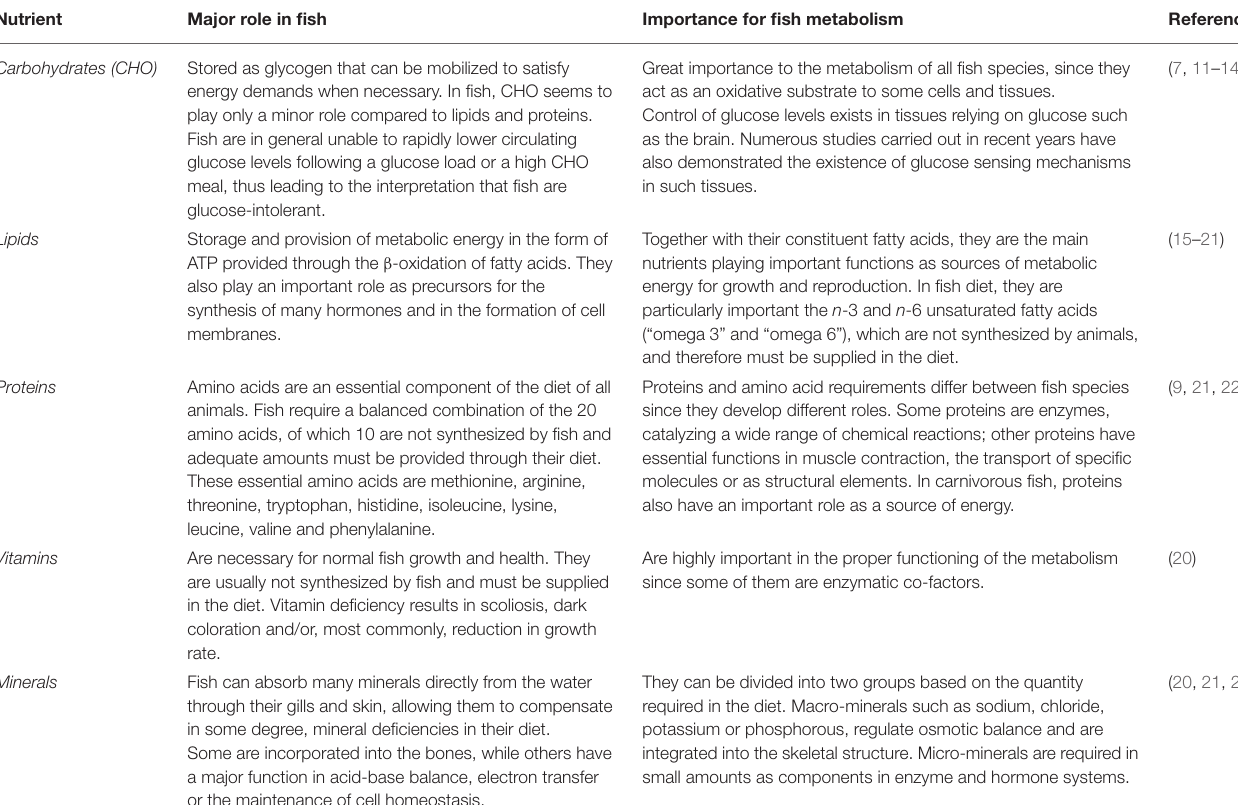
TABLE 1 | The role of principal macronutrients in fish